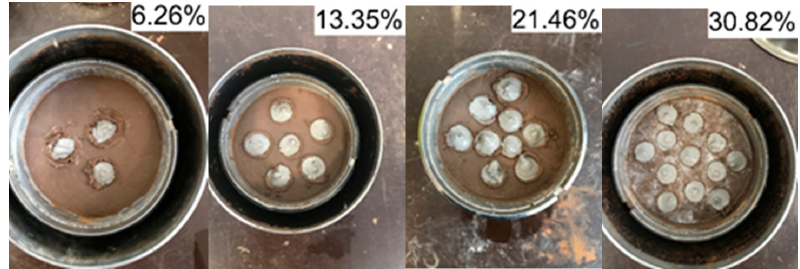
Figure 4. Cylindrical samples with the alkali activated GGBFS piles (the number at the right corner of pictures shows geopolymer volume quantity from clay volume, %). pictures shows geopolymer volume quantity from clay volume,